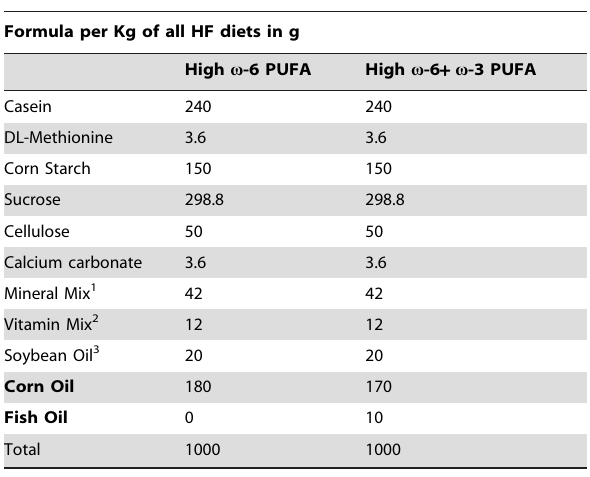
Table 2. Composition of high-fat